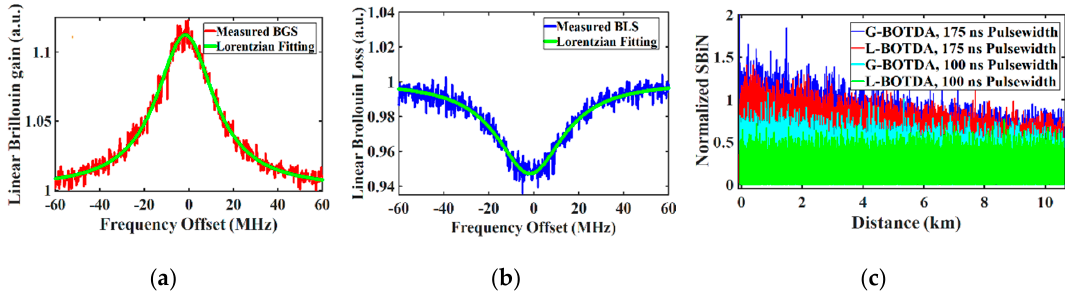
Figure 9. Measured Brillouin spectrum at a generic fiber position for 17.5 m spatial resolution: ( a ) gain case; ( b ) loss; ( c ) root mean square (RMS) noise measurement of the gain and loss case in the frequency domain along the fiber.